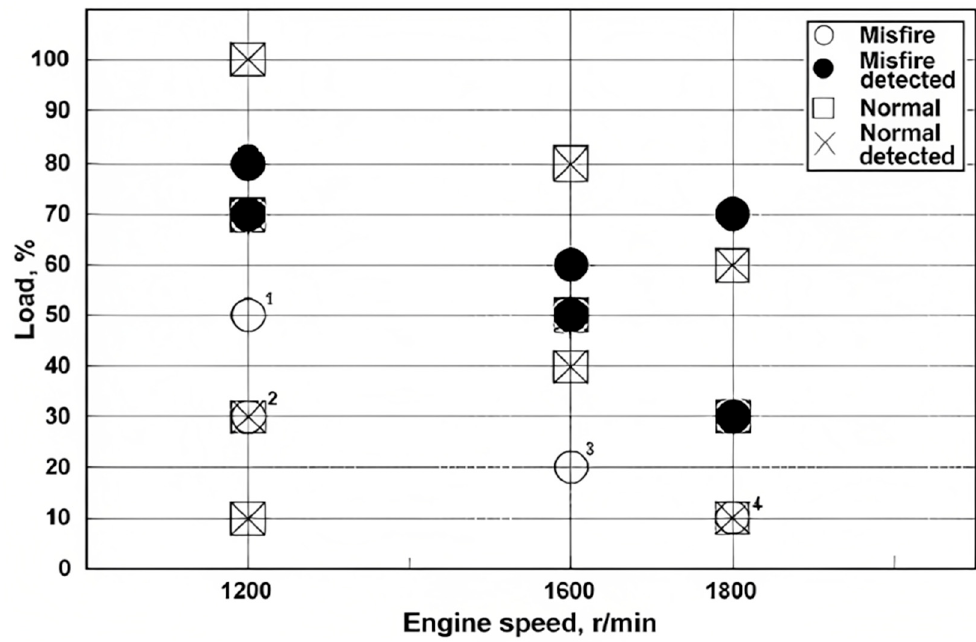
Figure 18. Verification of trained NN at the first trial.